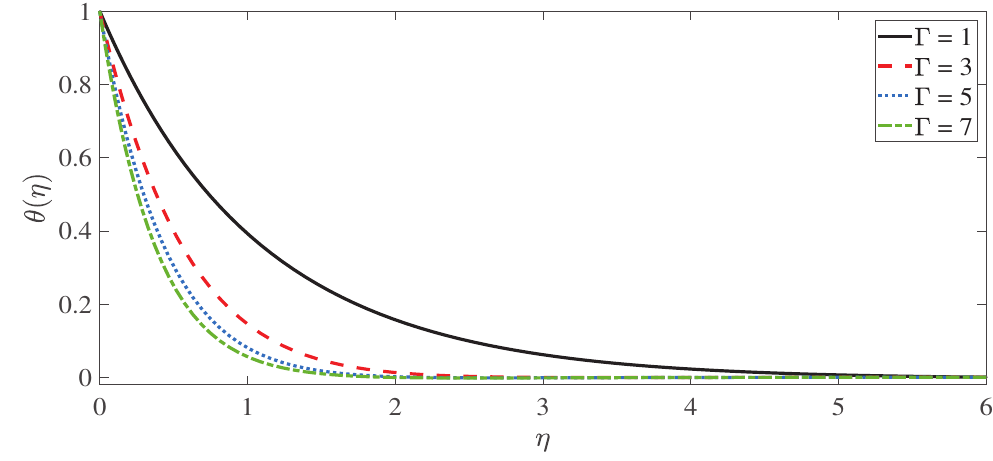
Figure 8. Temperature profile for Prandtl number Γ .